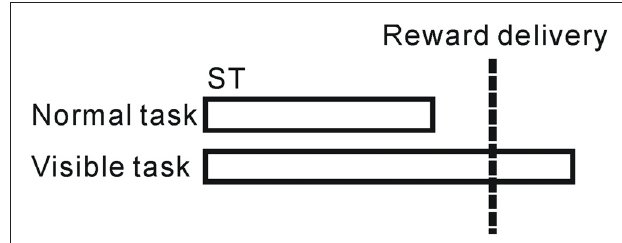
FIGURE 1 | Schematic illustration of the normal and visible tasks. In the normal task, the saccade target (ST) disappeared before the reward delivery, while in the visible task, the ST remained visible even after the reward